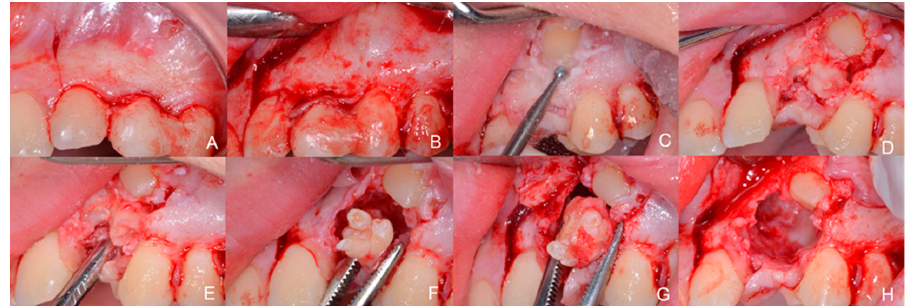
Figure 2. Intra-oral photographic images at baseline. ( A , B ) Front and side view before surgery; ( C , D ) Detail in the lateral and occlusal view with a temporary prosthesis in place 23. An expansion of the bone cortex is visible in line with the odontoma and the permanent area of the canine.